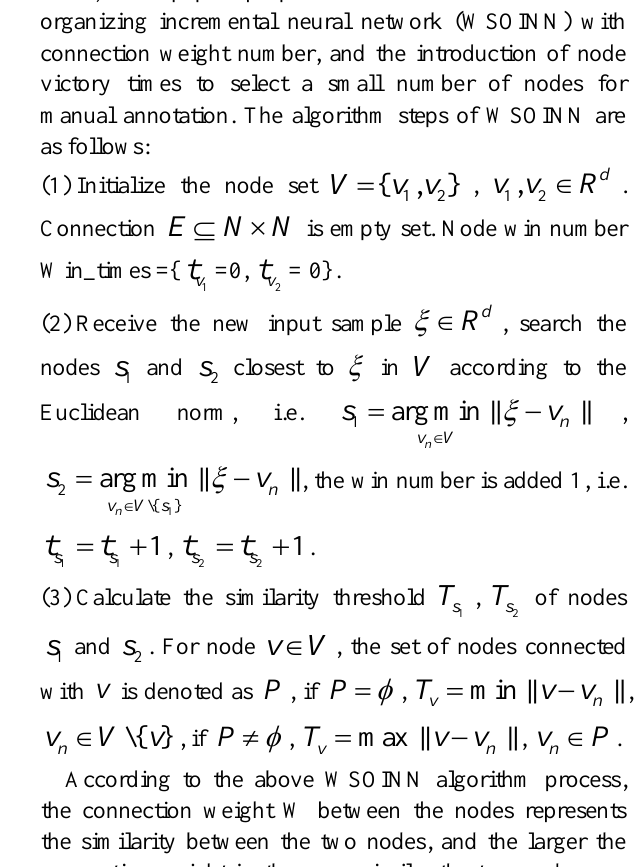
Figure 3. WSOINNGCN model